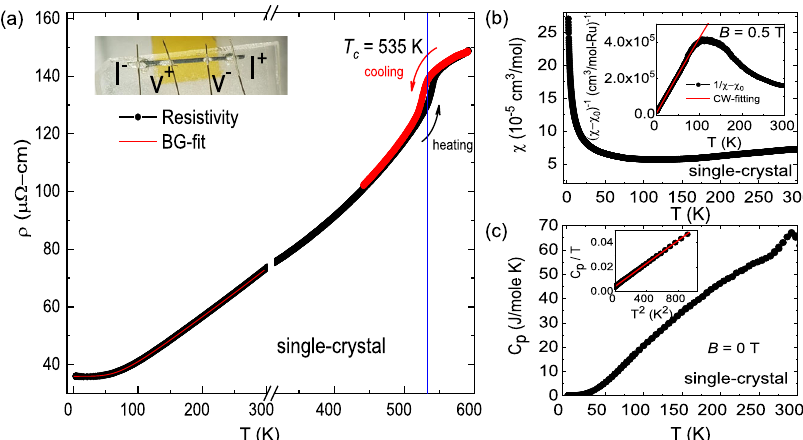
Fig. 1 Bulk properties. a The electrical resistivity data as a function of temperature is taken over single-crystal with the solid red line for the Bloch – Grüneisen model. Inset shows the single crystal used for the four-probe resistivity measurements. b Magnetic susceptibility ( χ ) measured at an applied magnetic fi eld B = 0.5 T. The inset shows inverse susceptibility with the modi fi ed Curie – Weiss law (solid red line). c Temperature dependence of the speci fi c heat C p measured at zero fi elds ( B = 0 T). Solid black circles are the raw data with C p / T shown in the inset of the fi gure while solid red line is the corresponding C p /T = γ + β T 2 fi tting.